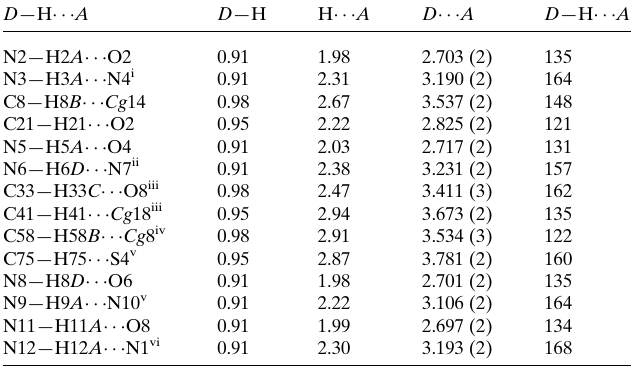
Table 3 Hydrogen-bond geometry (A˚ , (cid:4) ). Cg 8, Cg 14 and Cg 18 are the centroids of the C36–C41, C70–C75 and C86–C91 benzene rings,